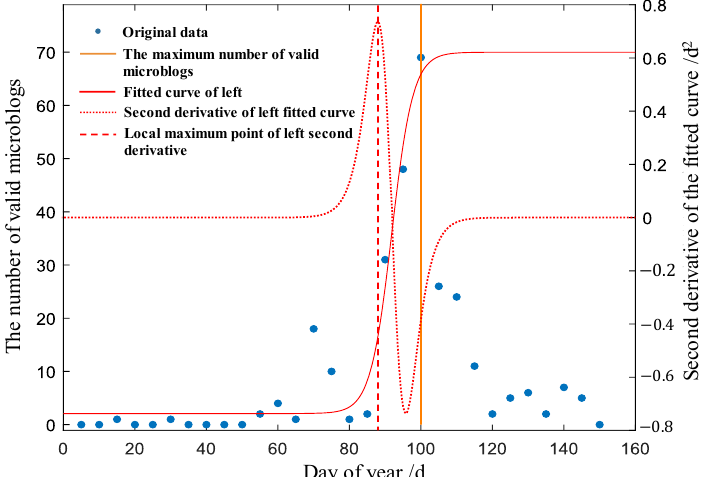
Figure A2. A schematic diagram for extracting the outbreak dates of pollen allergies based on valid microblog data.